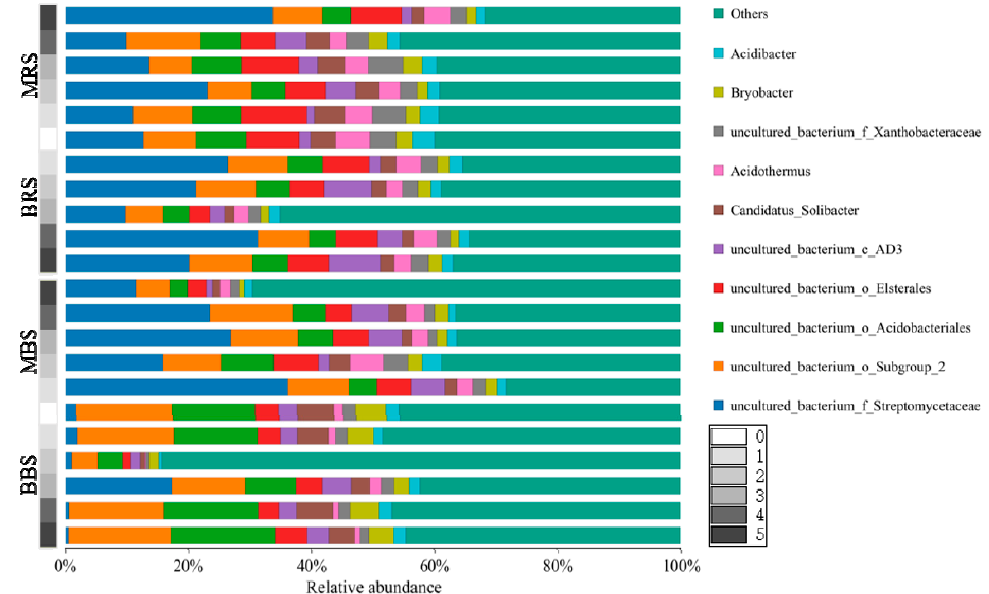
Figure 7. The relative abundances of top 10 main bacterial genera. B and M indicate bamboo biochar and bacteria-inoculated biochar; BS and RS indicate bulk soil and rhizosphere soil. 0, 1, 2, 3, 4, and 5 indicate control, 2.22 t·ha − 1 , 4.44 t·ha − 1 , 6.67 t·ha − 1 , 8.89 t·ha − 1 , and 11.11 t·ha − 1 .